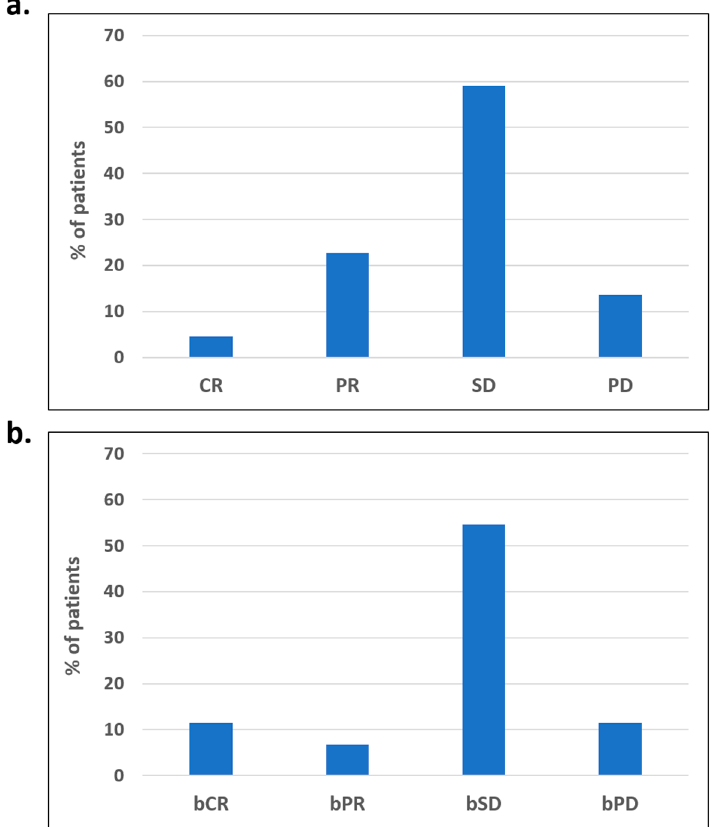
Figure 1. Analysis of responses. ( a ) Responses according to RECIST 1.1 criteria—CR—complete re- sponse; PR—partial response; SD—disease stabilization, PD—progressive disease. ( b ) Biochemical